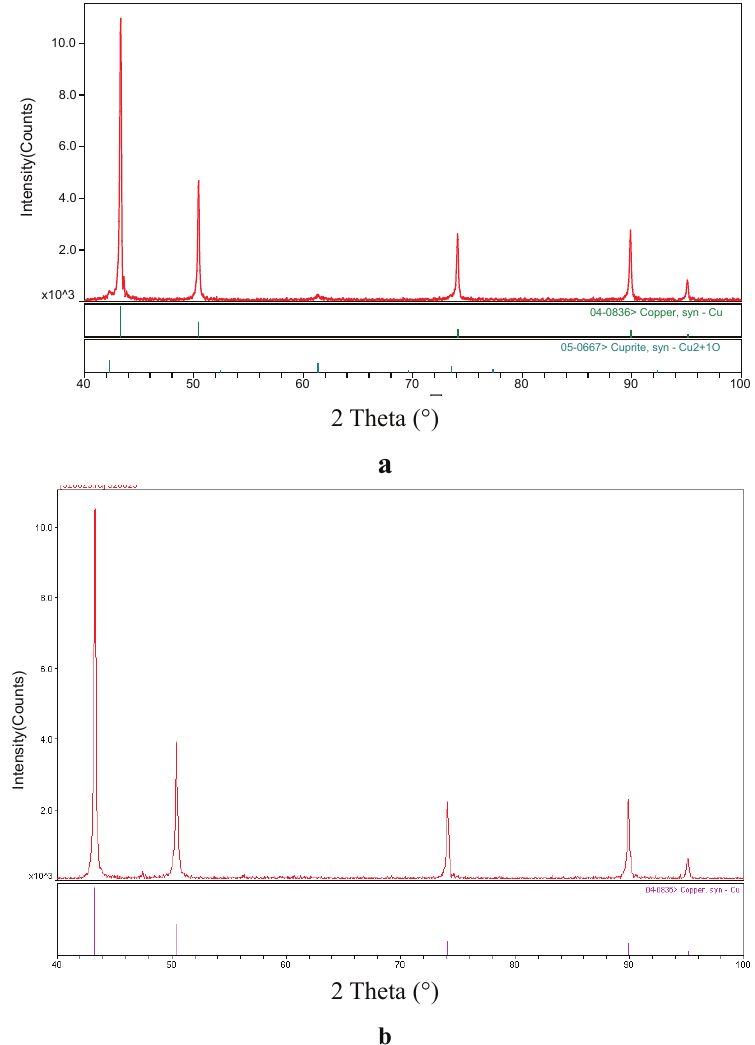
Figure 3. ( a ) XRD pattern of Cu nanopowders prepared using CuCO ( b ) XRD pattern of Cu nanopowders prepared using CuCl precursor raw